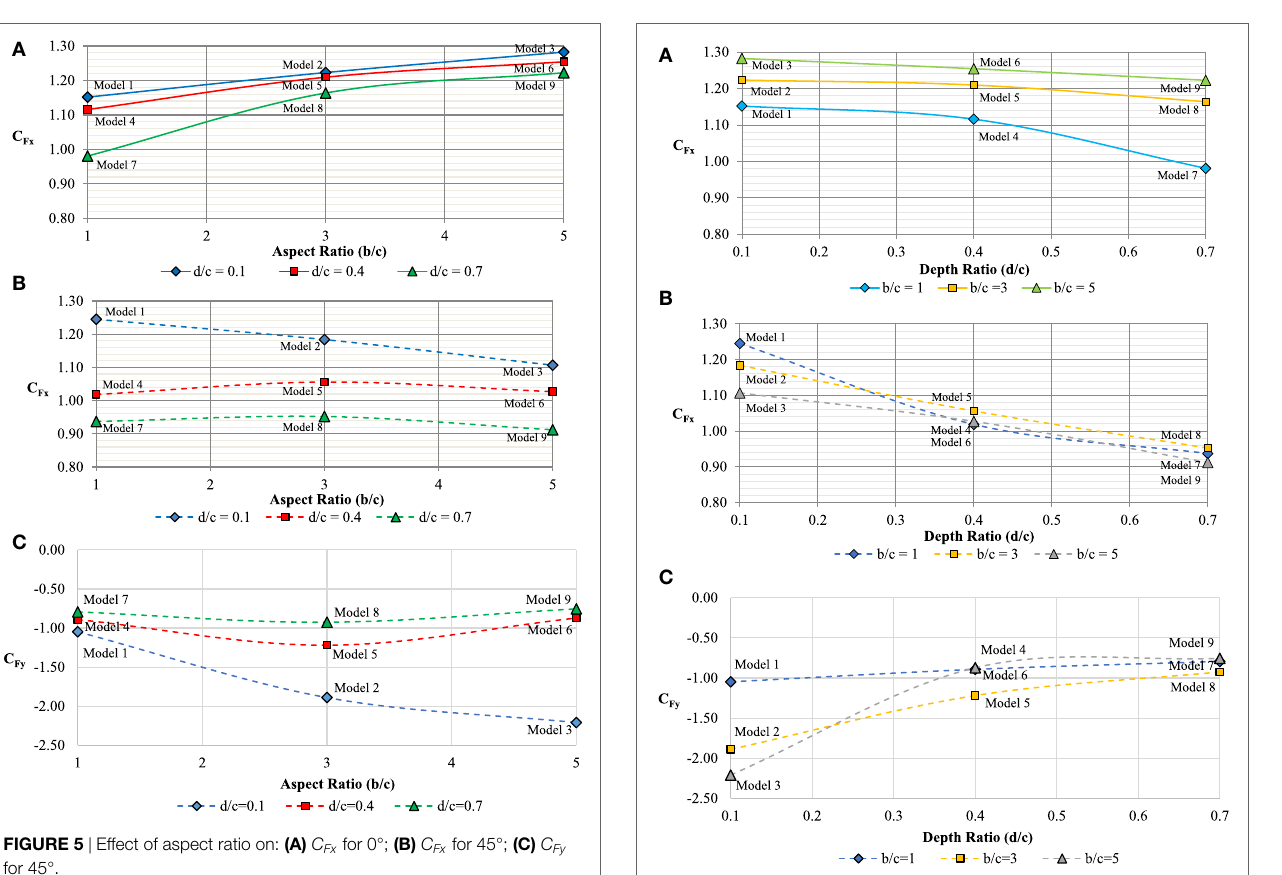
b / c = 1, 3, and 5. Results show that C Fx for the 45° wind direction also decreased with increasing depth